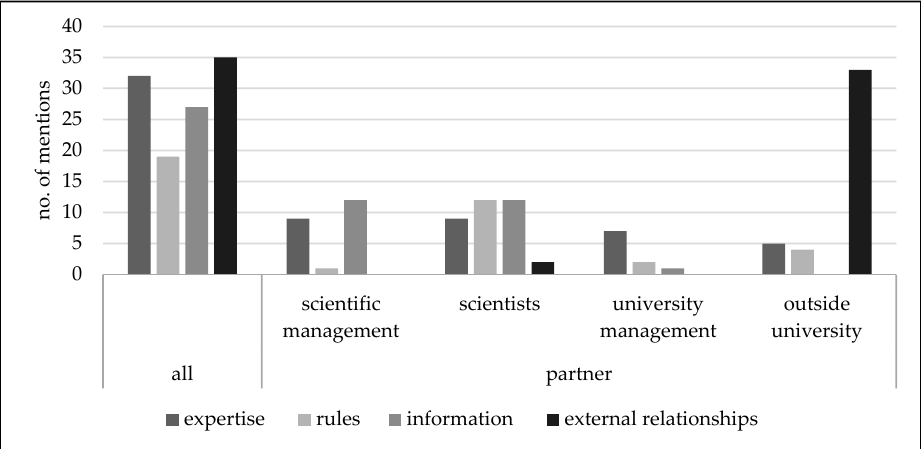
Figure 2. Use of power resources by science managers by a relationship partner. Used tactics